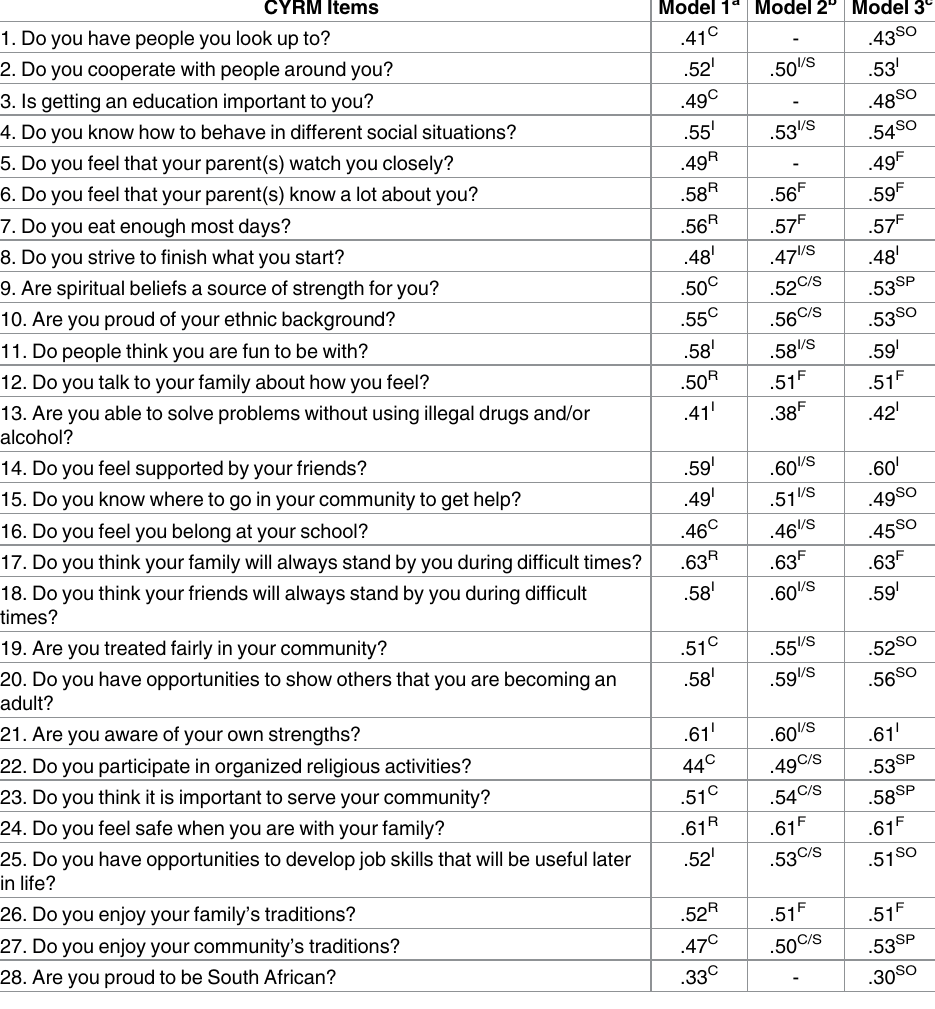
Table 2. Standardized CYRM item-factor loadings for all tested